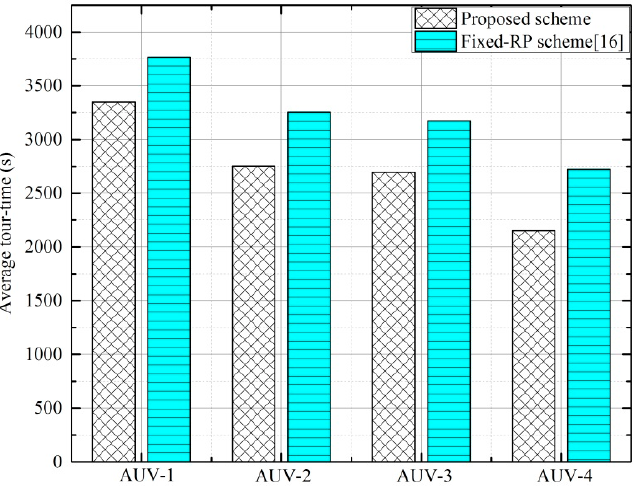
Figure 13. Average end-to-end delay versus the number of tour-points, N t .